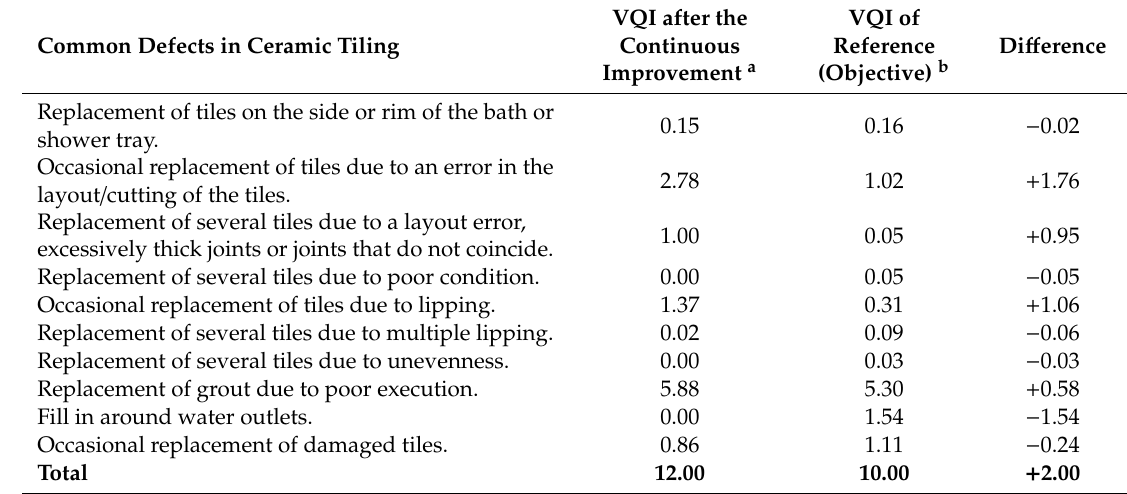
Table 9. Cost quality index (CQI) obtained and compared with the index of reference (objective) established in the Plan Phase. Common Defects in Ceramic Tiling Replacement of tiles on the side or rim of the bath or shower tray. Occasional replacement of tiles due to an error in the layout / cutting of the tiles. Replacement of several tiles due to a layout error, excessively thick joints or joints that do not coincide. Replacement of several tiles due to poor condition. Occasional replacement of tiles due to lipping. Replacement of several tiles due to multiple lipping. Replacement of several tiles due to unevenness. 5.64 € Replacement of grout due to poor execution. 89.26 € Fill in around water outlets. Occasional replacement of damaged